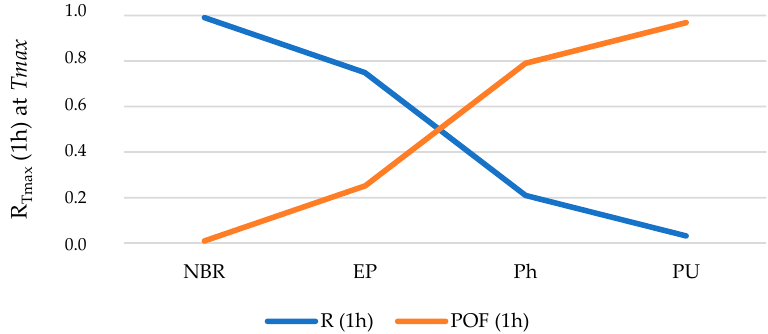
Figure 10. Reliability ( R ) and Probability of Failure ( POF ) after 1 h of operating at ( T max ).